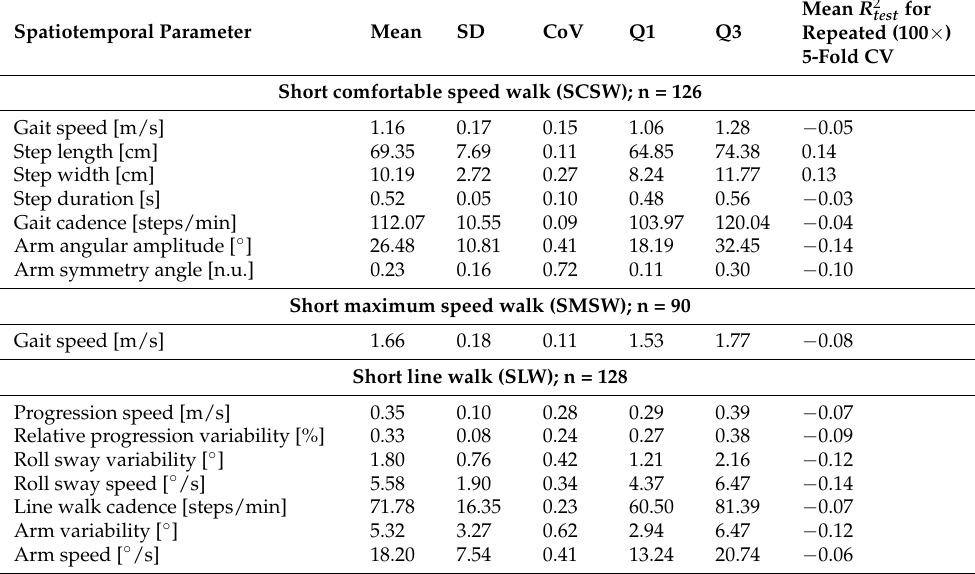
Table 3. Descriptive statistics of spatiotemporal parameters and generalizability estimates regarding linear models describing associations with confounders age, sex, height, and weight. Abbreviations: AP: anterior-posterior; CV: cross-validation; CoV: coefficient of variation; n.u.: unitless; Q1: 25th percentile; Q3: 75th percentile; RR: Romberg ratio; SD: standard